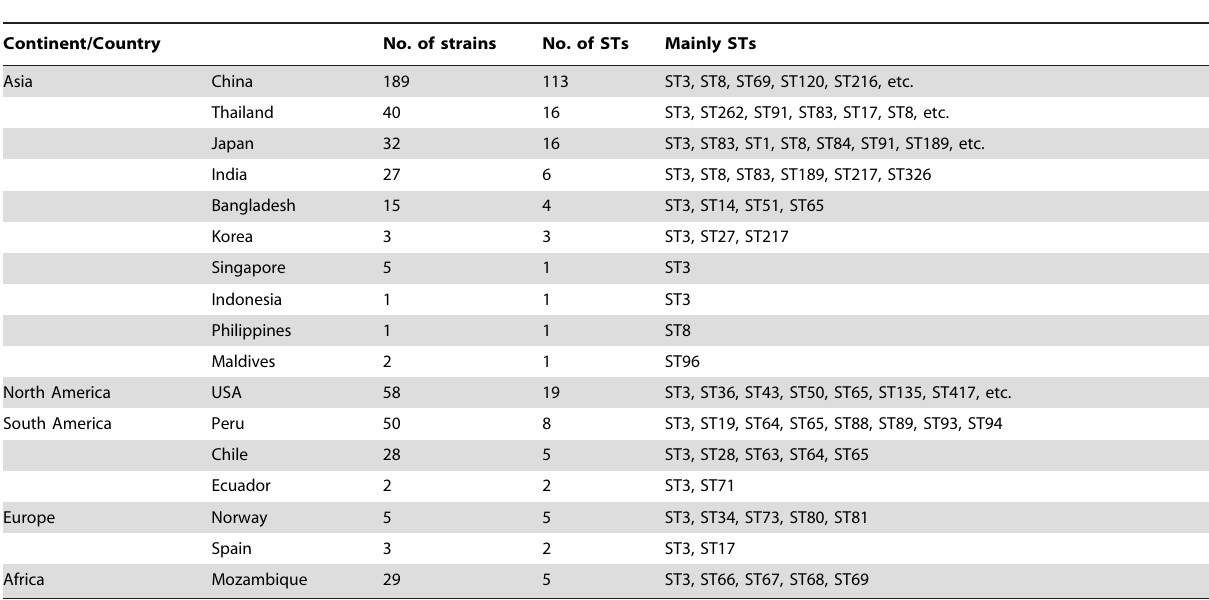
Table 2. Geographic distribution of the 490 Vibrio parahaemolyticus Isolates.